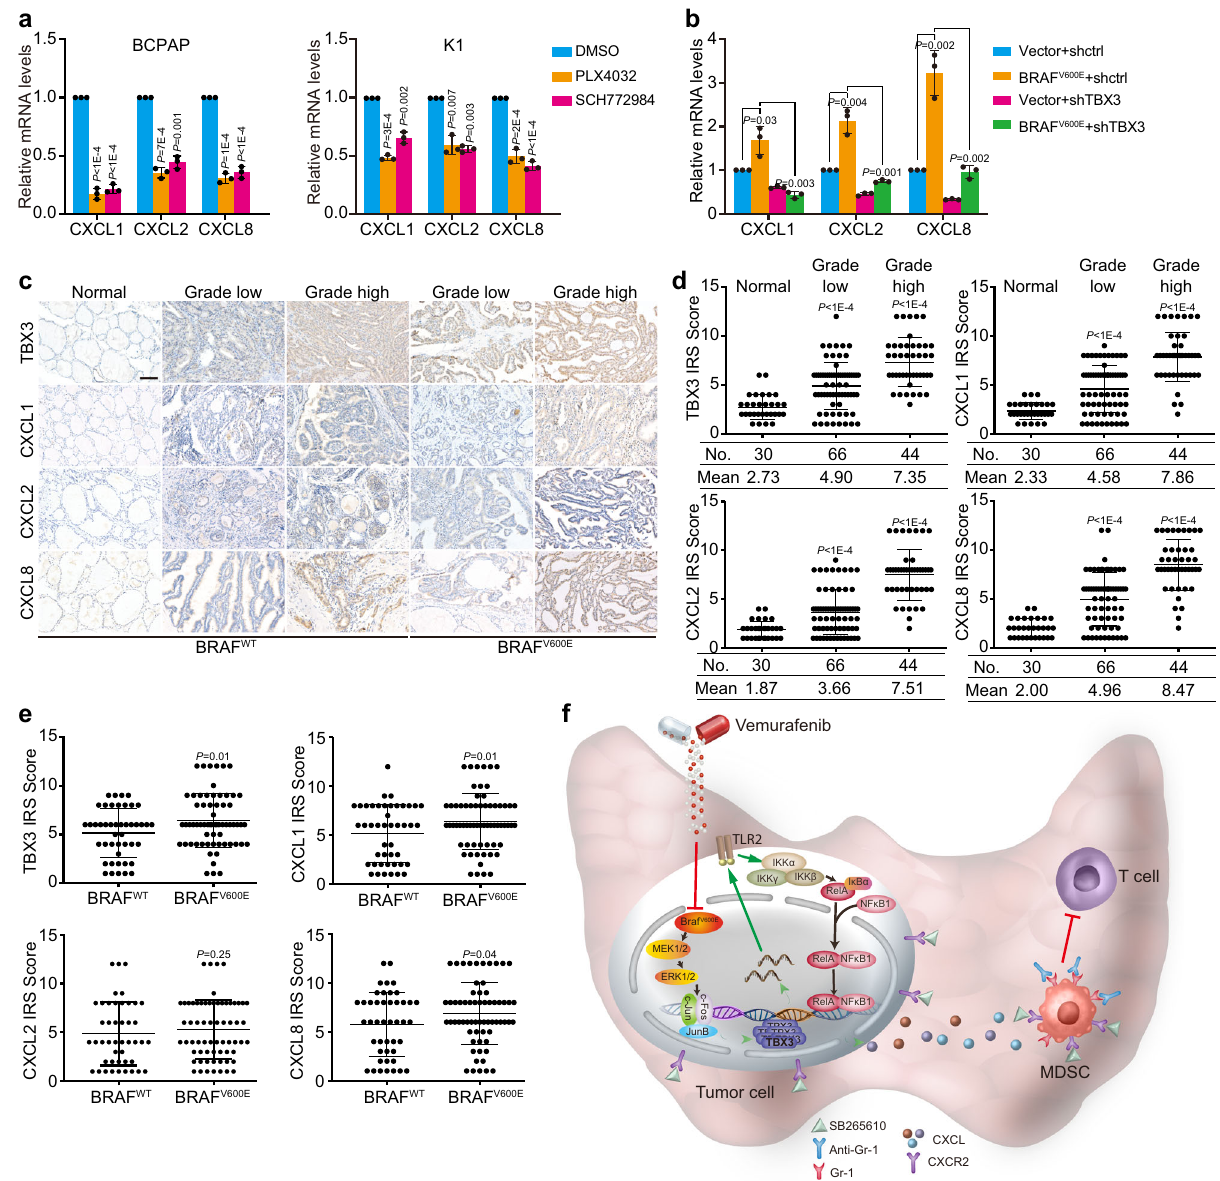
Fig. 8 BRAF V600E promotes CXCLs level and MDSCs in fi ltration through TBX3-regulated pathway. a Levels of CXCLs in PTC cells underwent PLX4032 or SCH772984 treatment were checked by RT-qPCR. b Levels of CXCLs in K1 cells stably over-expressing control Vector or BRAF V600E and subsequently infected with lentiviruses expressing TBX3 shRNAs were analyzed by RT-qPCR. c , d IHC staining in PTC samples with BRAF WT or BRAF V600E paired with adjacent normal tissues. Representative images were shown ( c ), and the scores of the stained sections were plotted ( d ), n = 30 normal tissues, n = 66 grade low PTC tissues, and n = 44 grade high PTC tissues. Scale bars, 100 μ m. e Scatter diagrams of TBX3, CXCL1, CXCL2 and CXCL8 protein levels in BRAF WT ( n = 45) and BRAF V600E ( n = 65) PTC tissues. f A proposed model of the mechanism of re-activation of TBX3 by BRAF/MAPK constitutive activation leading to immune-suppression by recruiting MDSCs into tumor microenvironment and the rational of combination therapy using PLX4032 and SB265610 or anti-Gr-1 to treat thyroid cancer. n = 3 biological independent samples ( a , b ). Data are shown as the mean ± s.d. ( a , b , d , e ). P values were calculated by unpaired two-tailed Student ’ s t test ( a , b , d , e ). Statistical source data are provided in Source Data. isolation of tumor cells was next performed on FACSAria Cell Sorter (Becton Dick- administered intraperitoneally six times a week with 2mg/kg body weight, n = 7 inson) according to GFP signal, and positive cells were washed with PBS and then per group. Mice bearing mPTC and mPTC/Tbx3 − / − tumors were treated with cultured in F-12 medium supplemented with 10% FBS, 1% penicillin/streptomycin, 200 μ g anti-CD8 antibody (#BE0061, Bio-XCell) and igG2a control per mouse 5mg/L transferrin (Sigma-Aldrich), 10mg/L bovine insulin (Solarbio), 3.5mg/L twice weekly at age of 3 w for 20 d. Mice were sacri fi ced and isolated tumors were hydrocortisone (Sigma-Aldrich), 10mg/L somatostatin (Sigma-Aldrich), 0.02mg/L used for fl ow cytometry analysis or immunohistochemical analysis. Gly-His-Lysacetate (Sigma-Aldrich) and 1 IU/L bovine thyroid stimulating hormone (TSH) (Sigma-Aldrich) related to the 6H medium at 37°C 59 . Next, Primary cells treated Primary cell culture . Cancer tissues obtained from mPTC GFP were minced in lysis with 10 μ M PLX4032 or 2 μ M SCH772984 were subjected to western blot and RT-qPCR buffer (Collagenase I (Sigma) 1mg/ml; Dispase II (Invitrogen) 0.5mg/ml in PBS) and analysis. Primary cells from mPTC mice were directly cultured in complete F-12 shaked on an orbital shaker at 37°C for 60min. Dissociated tumor cells were fi ltered medium. Thyrocytes were con fi rmed by immuno fl uorescence staining of thyroglobulin with 40 μ m cell strainer (#352340, BD Falcon) and centrifugated at 500 g for 5min, the and representative photos were taken by a fl uorescence microscopy. pellet was resuspended in cold Ham ’ s F-12 Nutrient Mix (#11765062, Gibco). The NATURE COMMUNICATIONS| (2022) 13:1588